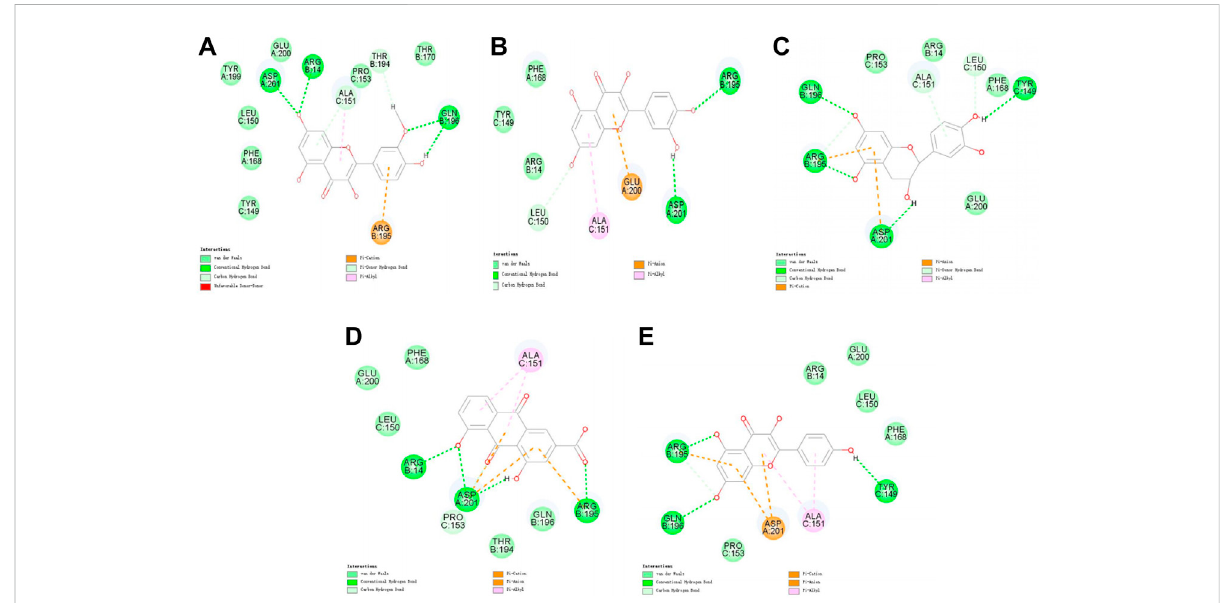
FIGURE 4 2D interaction map of CKIP-1 with selected small-molecule compounds. (A) Isorhamnetin; (B) quercetin; (C) ent-epicatechin; (D) rhein; (E) kaempferol.